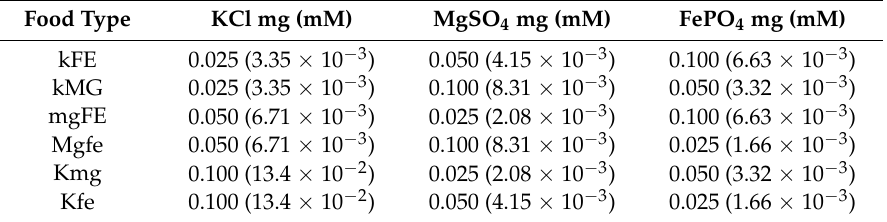
Table 1. Total amounts of KCl, MgSO 4 , and FePO 4 added to each food type. Amounts are listed as mg and resulting mM for each diet. For each food label, the element in lower case refers to the diet that was the lowest level in the enrichment and the element in upper case refers to the diet that was highest in the enrichment.